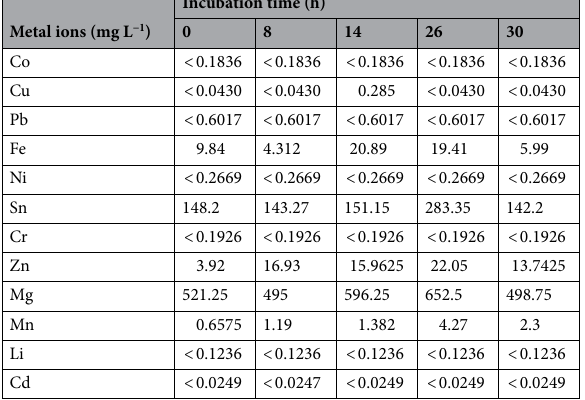
Metal ions (mg L −1